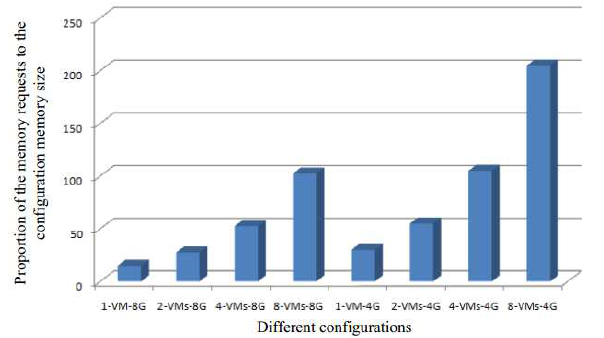
Figure 8. The proportion of memory requests for different configurations of the default